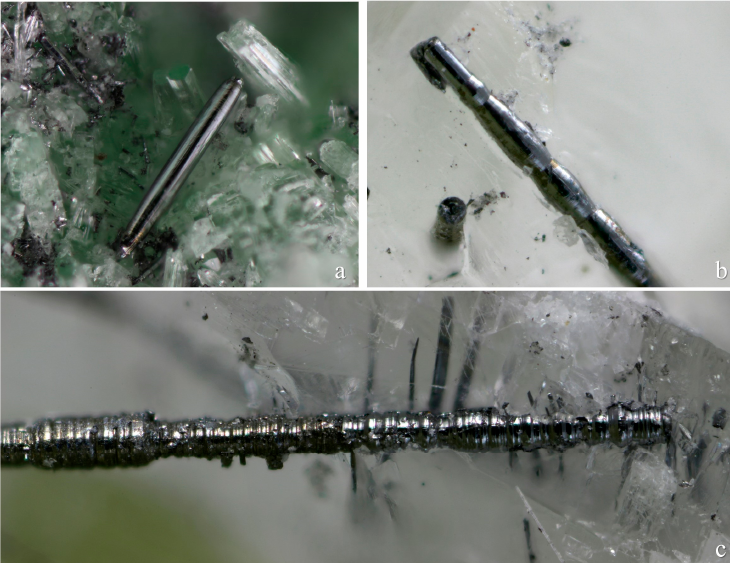
Figure 1. Optical photographs of merelaniite and some associated minerals: ( a ) 0.73-mm-long “cylindrical” whisker of merelaniite associated with tremolite, prehnite, and chabazite (private collection); ( b ) Whisker of merelaniite (0.9-mm section), associated with calcite, showing undulating diameters (Simon Harrison collection; sample 3941); ( c ) 2.5-mm section of a 5-mm-long merelaniite whisker (maximum diameter 0.18 mm) showing naturally unraveled ribbons, some partially enclosed in calcite, and associated with yellow prehnite (Simon Harrison collection; sample 3941).